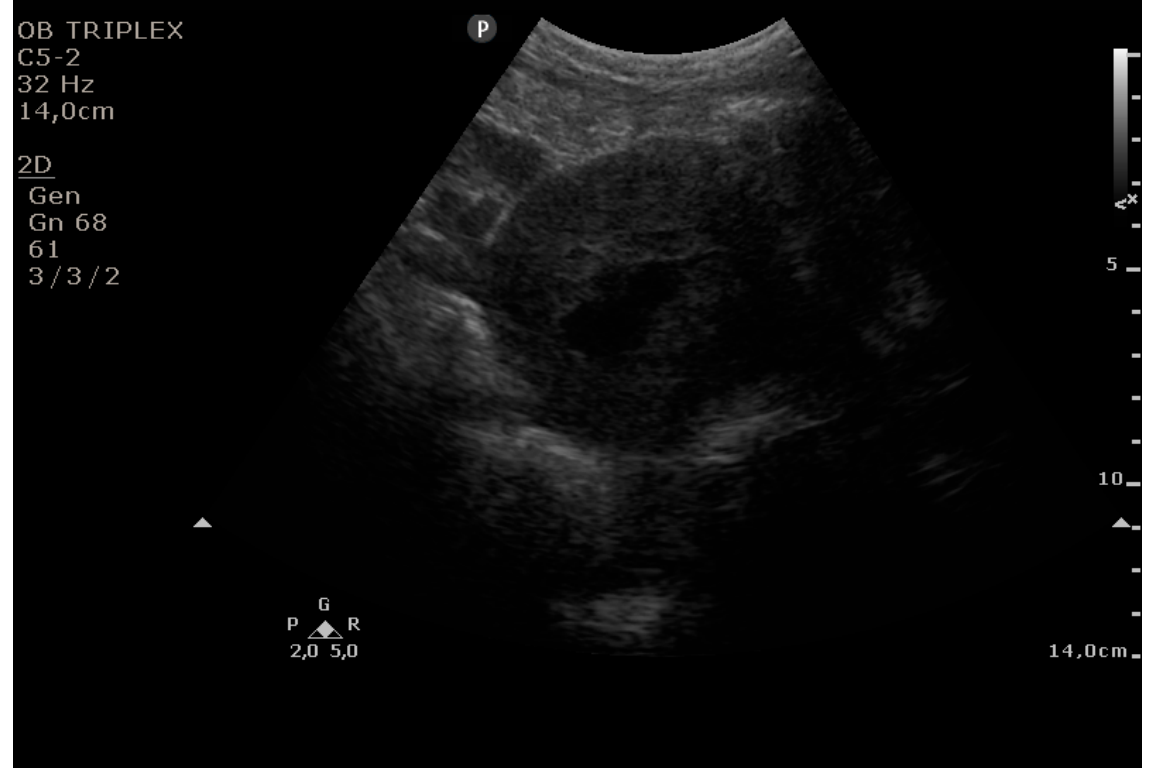
Figure 4. Grade 3: less than three-quarters of the endometrial length occupied by blood or debris.